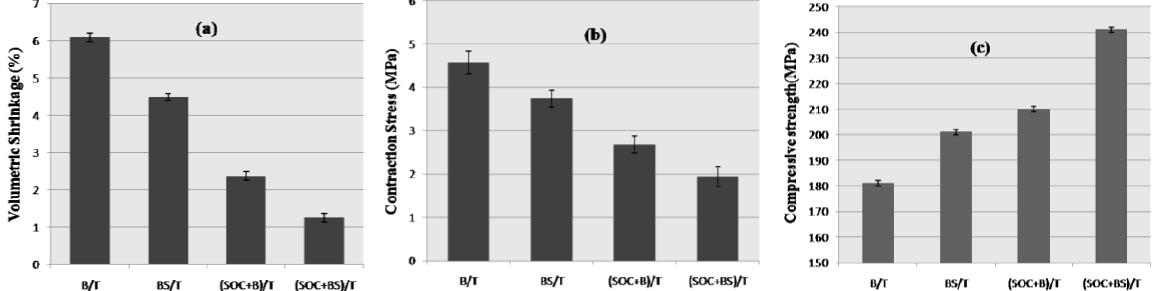
Figure 3. Volumetric shrinkage ( a ); contraction stress ( b ) and compressive strength ( c ) of the four groups of resin